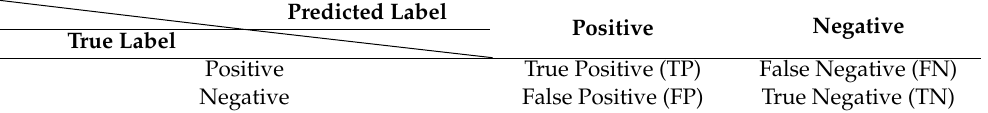
Table 2. Model prediction.